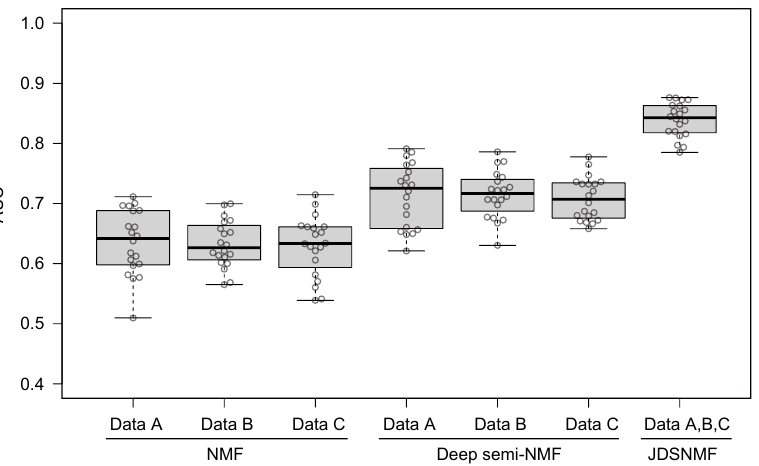
Figure 3. Test AUC comparison of NMF, deep semi-NMF, and JDSNMF on simulated